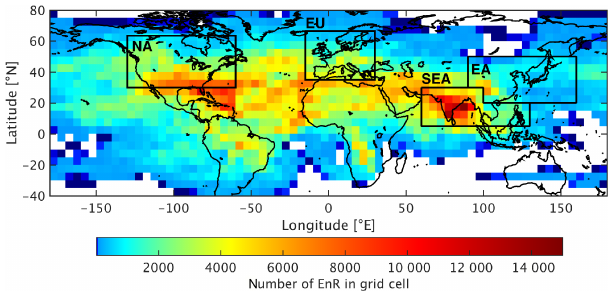
Figure 8. Geographical distribution of EnRs duplicated along the waypoints of the assigned 5-day back trajectories. Grid cells with- out data are left bank. Four areas of interest (rectangles) are consid- ered: North America (NA), Europe (EU), Southeast Asia (SEA) or East Asia (EA).